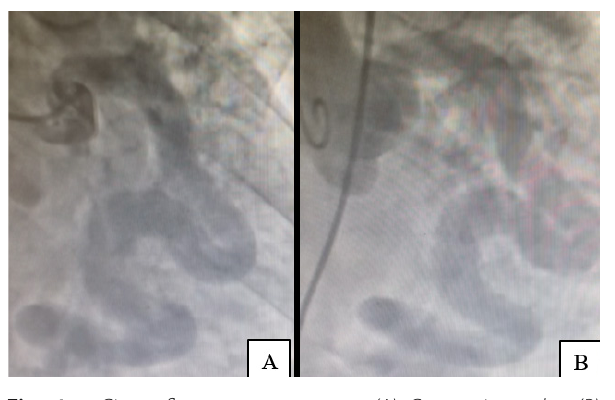
Fig. 1 - Circumflex artery aneurysm. (A) Coronariography. (B) Aortography.